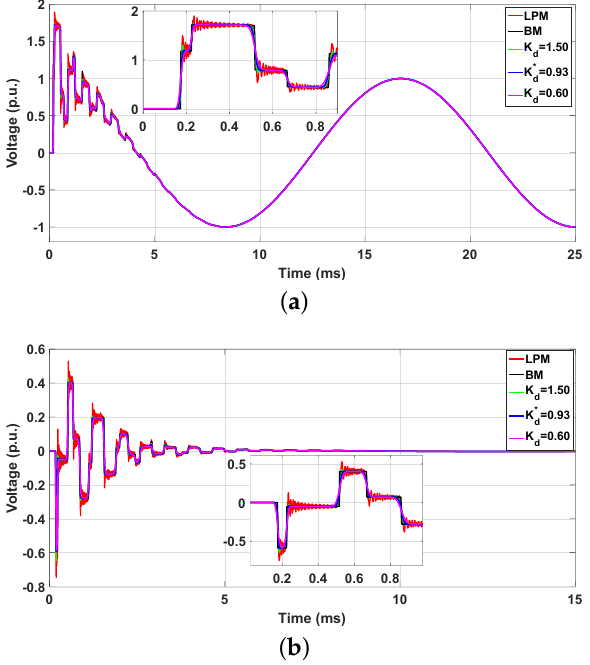
Figure 14. V m ( t ) in Scenario 4 for the LPM, T 1 and BM with K ∗ : ( a ) Phase 1 ( b ) Phase 2 (or Phase 3). d The percentage errors (cid:101) (%) based on voltage peaks illustrated in Figures 14 and 15 obtained with the LPM, with the modified topologies T 1 and T 2 for best adjustable factors and with BM for scenario 4 are shown in Table 5. In Figures 14 and 15, the energization generates surge waves that travel along the line, resulting in overvoltages at the receiving end. Due to the inductive and capacitive couplings between the phases, induced voltages are produced at phases 2 and 3. It can be seen that when a positive variation in the voltage at phase 1 induces negative voltages at phases 2 and 3, as predicted by Faraday’s law. In the steady state, the voltage at phase 1 will reach 1 p.u. while at phases 2 and 3 it is zero, due to the open-circuit condition. In these figures, one observes that the amplitude of NSO is significantly reduced when the three-phase line is represented by the modified topologies T 1 and T 2 . The voltage peaks and errors obtained are shown in Table 5. As noted, for the voltages in phase 1, the errors for the topologies T 1 and T 2 are equal to 0.82%,